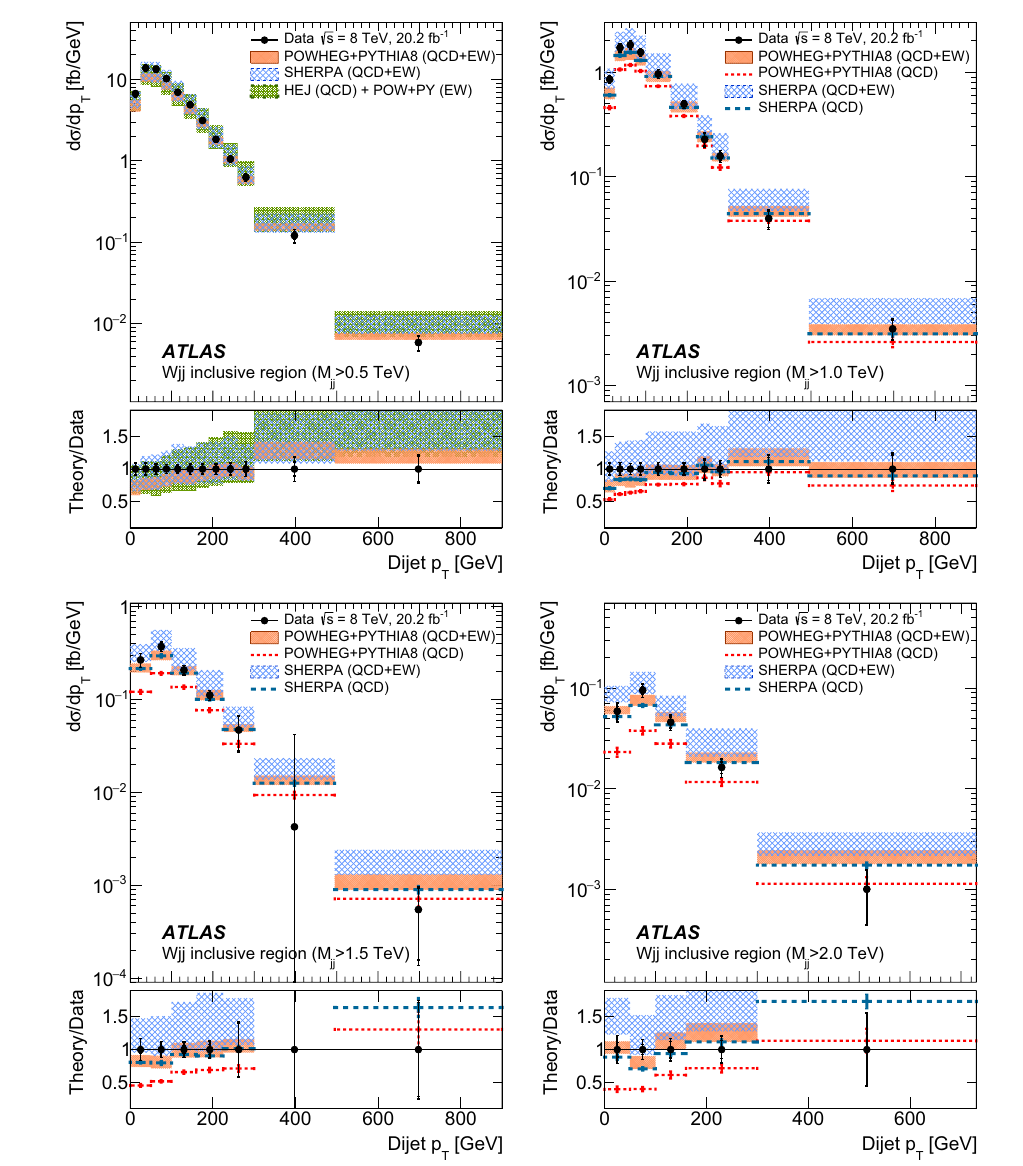
Fig. 46 Differential W jj production cross sections as a function of dijet p T in the inclusive fiducial region with four thresholds on the dijet invariant mass (0.5, 1.0, 1.5, and 2.0 TeV). Both statistical ( inner bar )